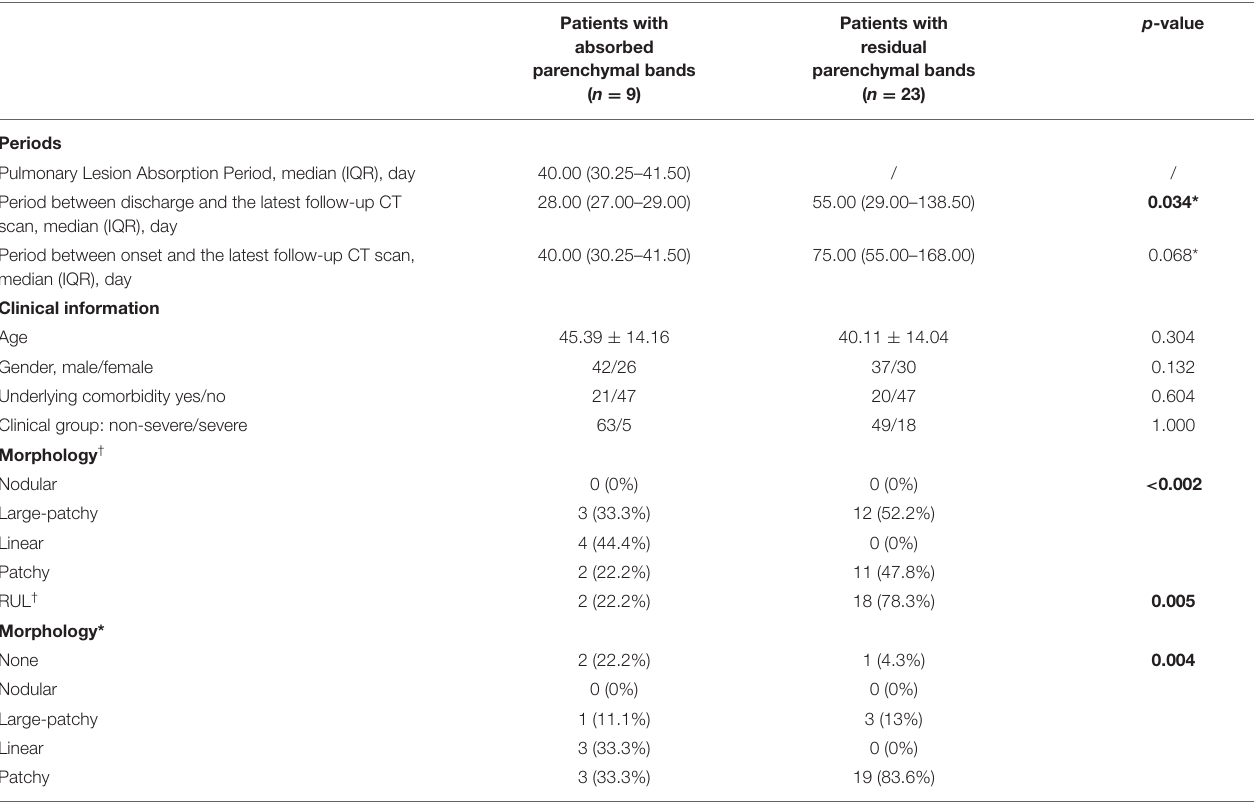
TABLE 5 | The comparison of clinical manifestations between the patients with COVID-19 with absorbed parenchymal bands and residual parenchymal bands in the last follow-up scan after discharge.